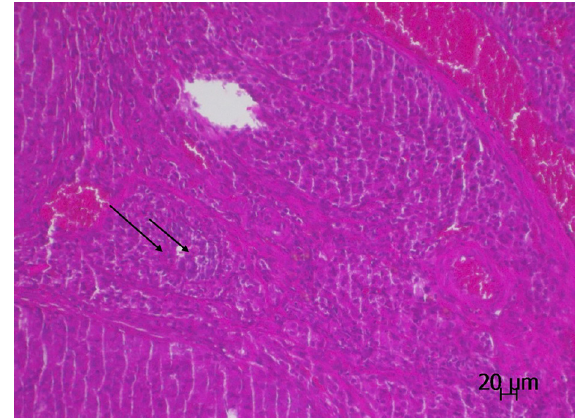
Figure 5. The section displaying the cystic change (star) and follicle cell degeneration (arrow) in the ovarian follicles of the OIR group